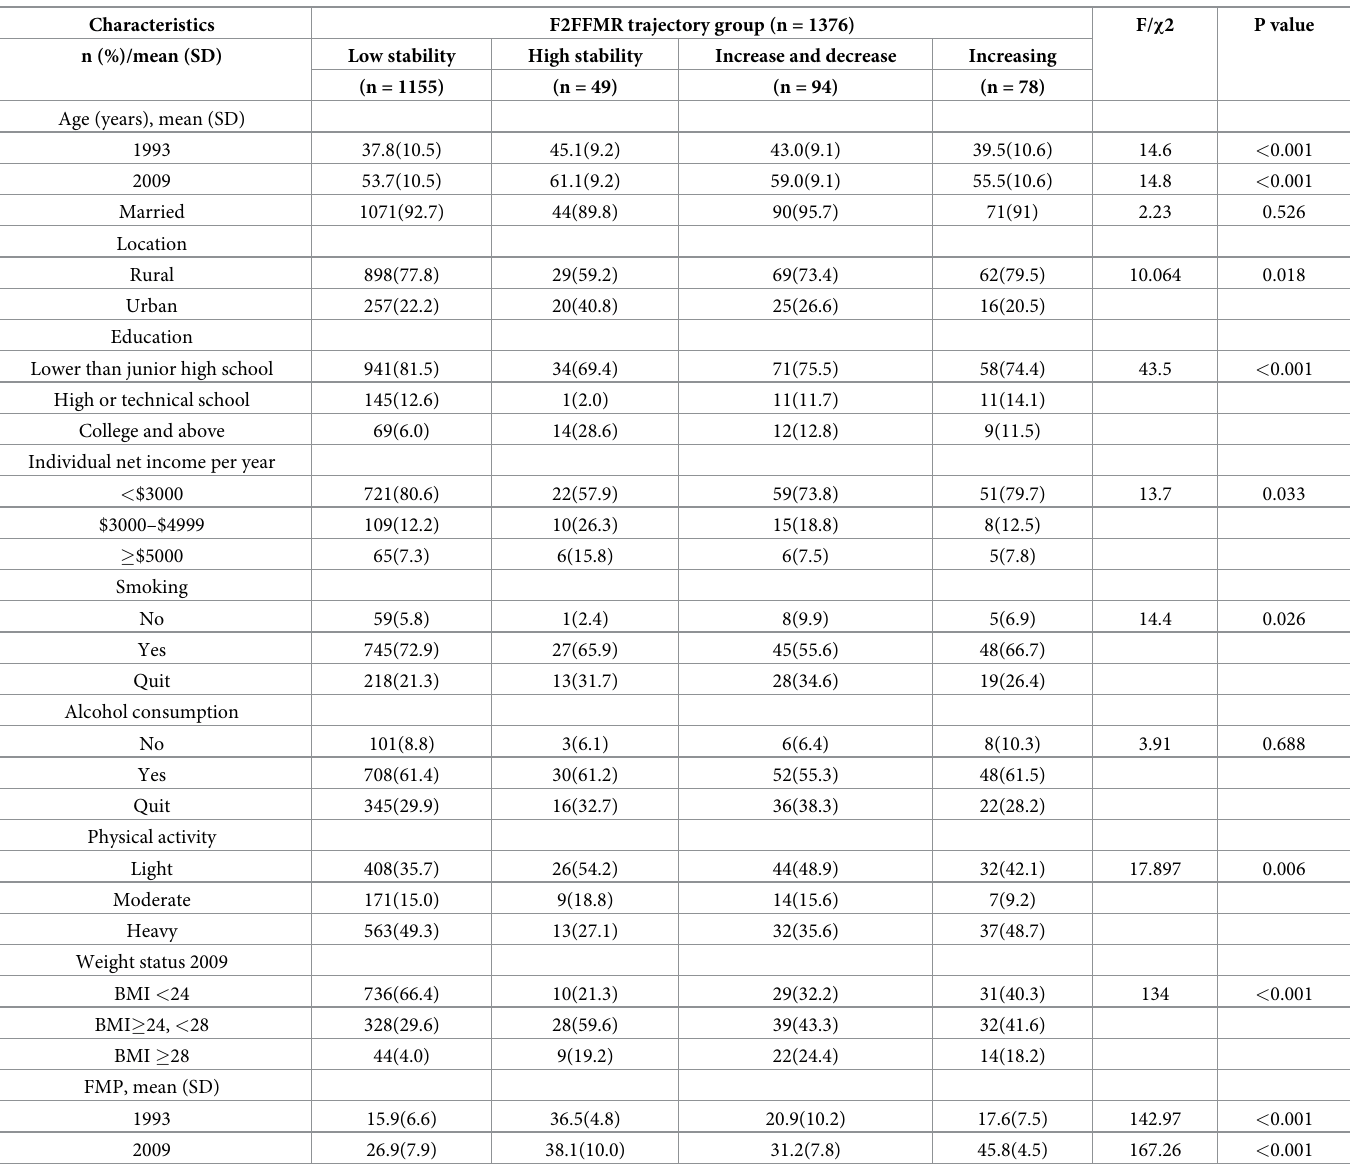
Table 2. Characteristics of the male participants, according to their latent F2FFMR trajectory